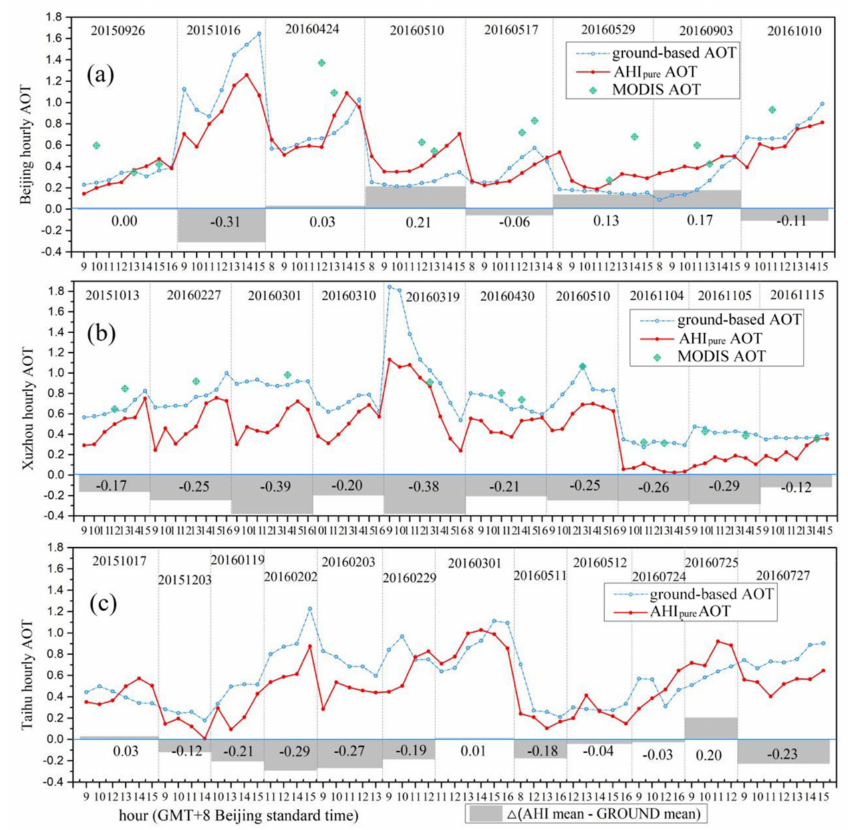
Figure 6. Di ff erences between retrievals of H8 / AHI version 010 and the ground-based measurements. ( a ) Beijing; ( b ) Xuzhou; ( c ) Taihu. The solid red line represents the daily mean of at least 7 AHI retrievals in one day (4 in panel c due to limited data), and the dashed blue line represents the ground match-up AOTs. The green points are the Moderate Resolution Imaging Spectroradiometer (MODIS) match-ups. The gray shaded columns and the number shown are the di ff erence between the two